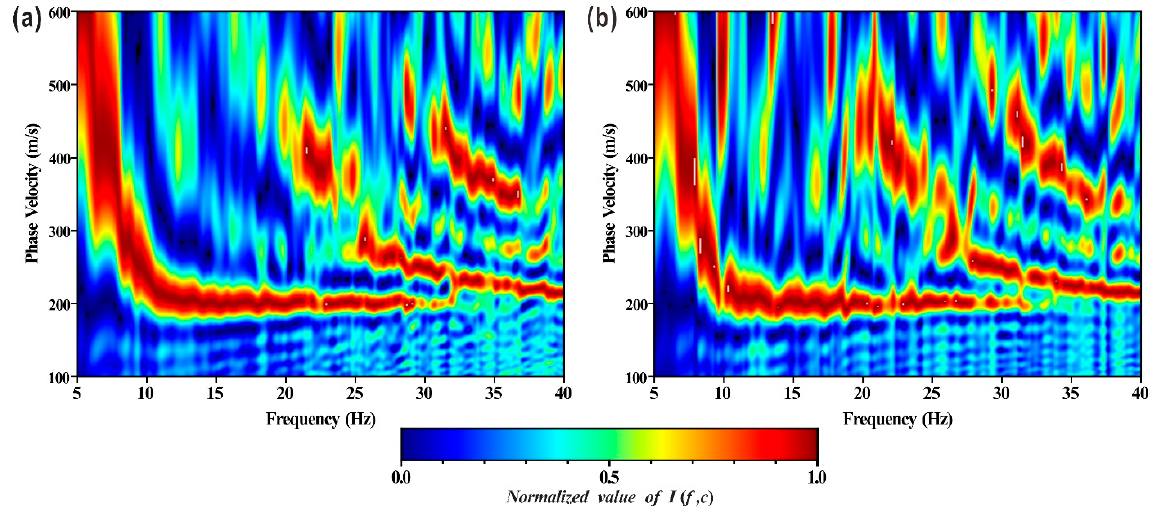
Figure 10. Rayleigh wave dispersion diagram extracted from measured array microtremor data using frequency-Bessel transform method. ( a ) Observation system 1; ( b ) observation system 2.